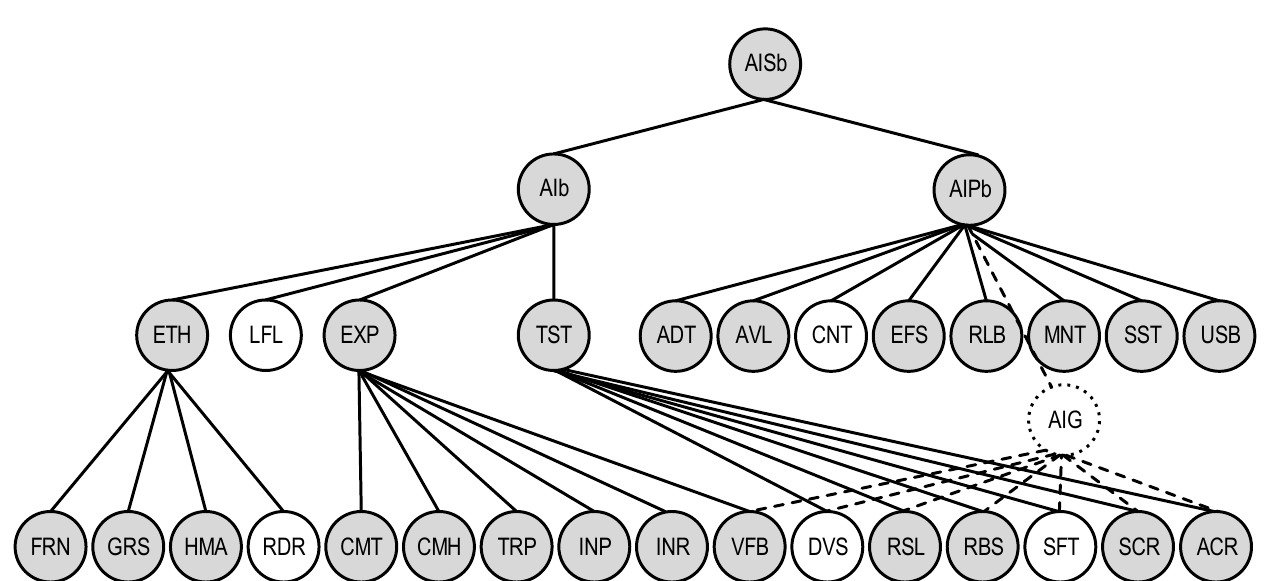
Figure 11. The graph representation of the quality model of the SDUD as an AI system with a built-in convolutional neural network.